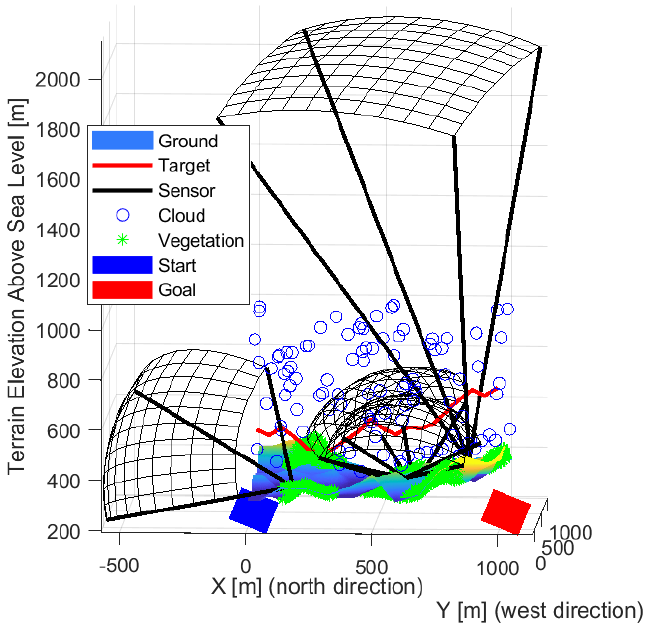
Figure 13. The solution in the case of the four sensors from the side